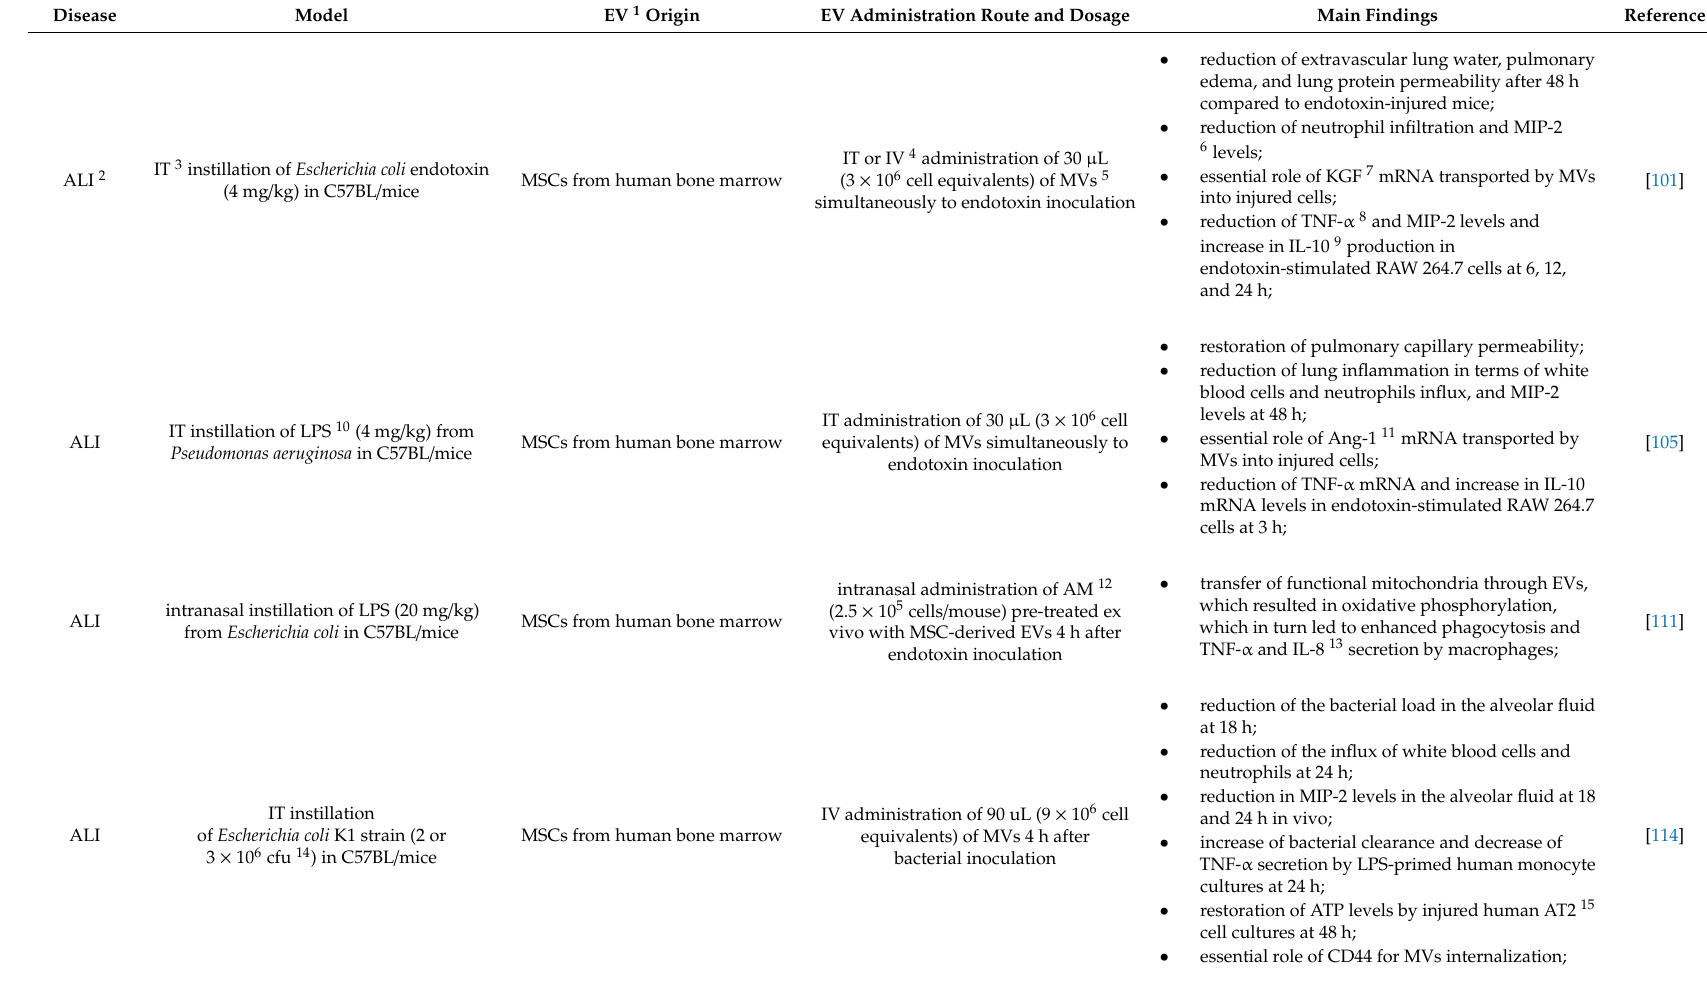
Table 1. Successful use of mesenchymal stem cell (MSC)-derived extracellular vesicles (EVs) (microvesicles (MVs) or exosomes) in lung